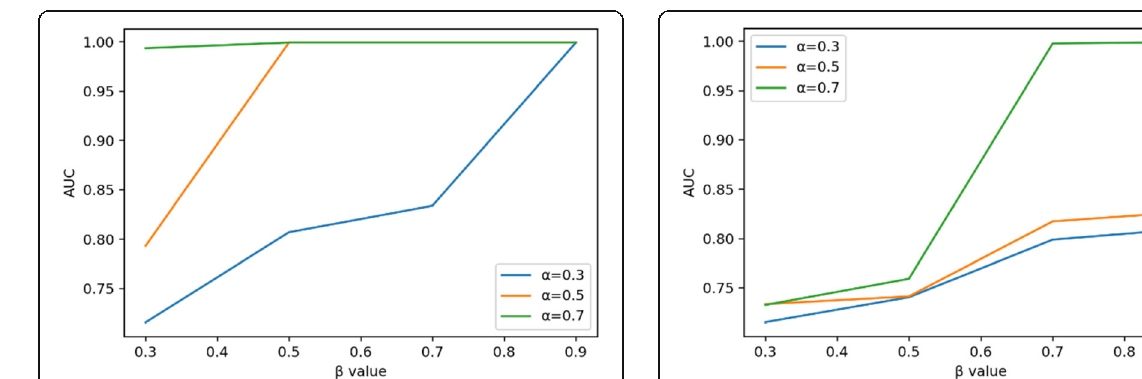
Fig. 9 The different parameters are employed in the function WJC KA to obtain AUC values. α = 0.3, α = 0.5, α = 0.7